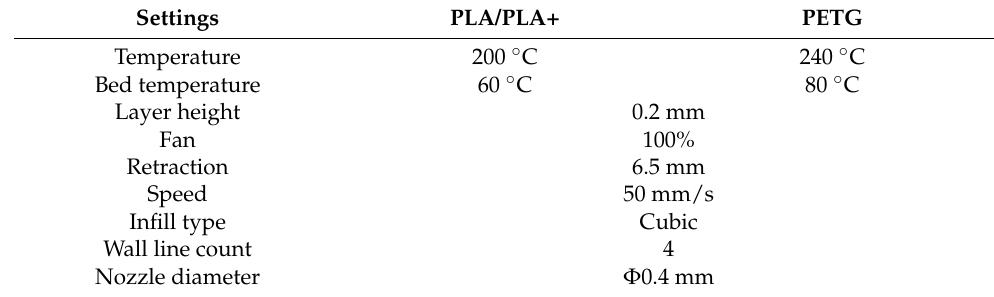
Figure 8. Z seam positions and printing direction: ( a ) random; ( b , c ) user-specified. Table 4. Process parameters.